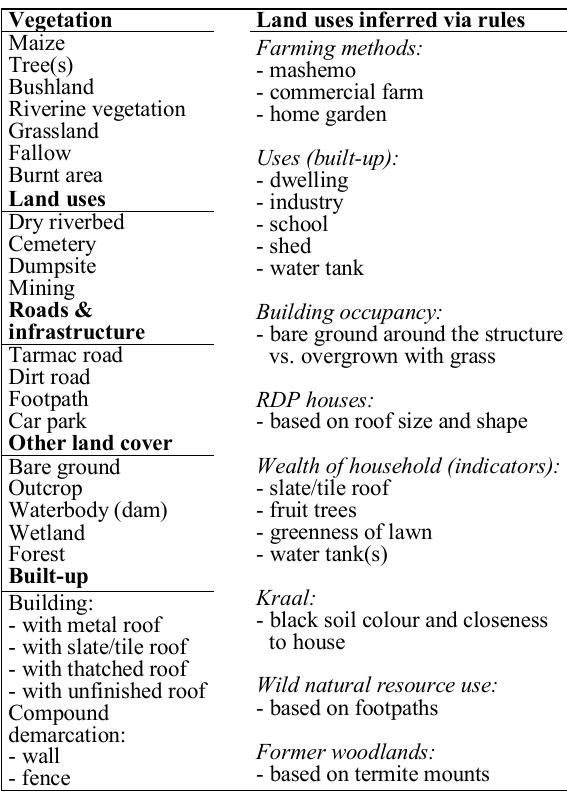
Table 3: LUC classes aimed at in OBIA. Vegetation Land uses inferred via rules Maize Tree(s) Bushland Riverine vegetation Grassland Fallow Burnt area Land uses Dry riverbed Cemetery Dumpsite Mining Roads & infrastructure Tarmac road Dirt road Footpath Car park Other land cover Bare ground Outcrop Waterbody (dam)